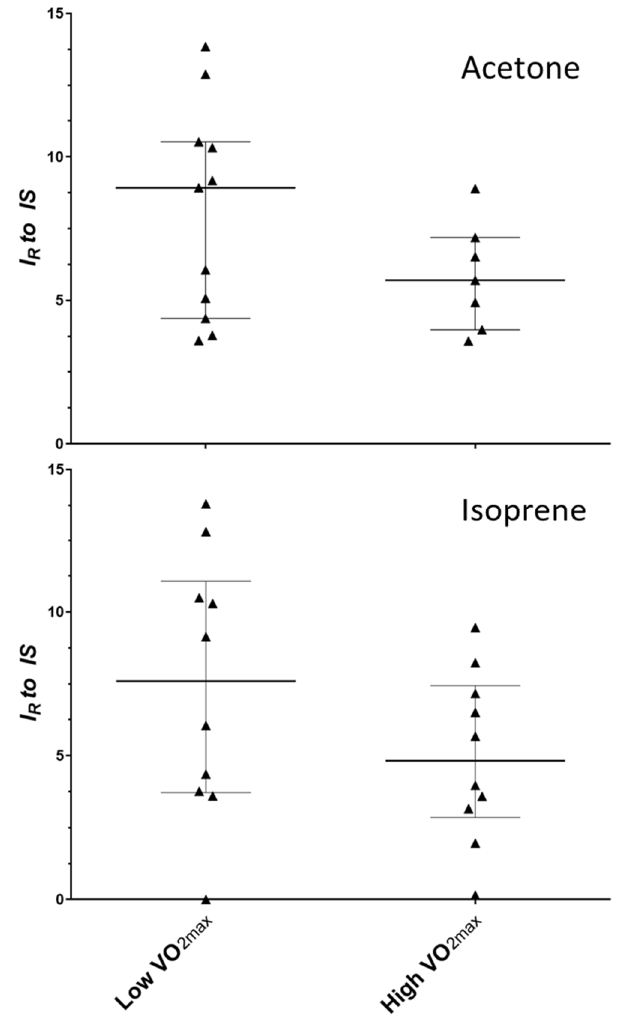
Figure 5. Plot to show the distribution of acetone ( top ) and isoprene ( bottom ) in low and high absolute VO 2MAX groups in a pre-exercise exhaled breath sample. Horizontal line is shown at the median with errors bars indicating the interquartile range. Note: I R = relative intensity; IS = internal standard.